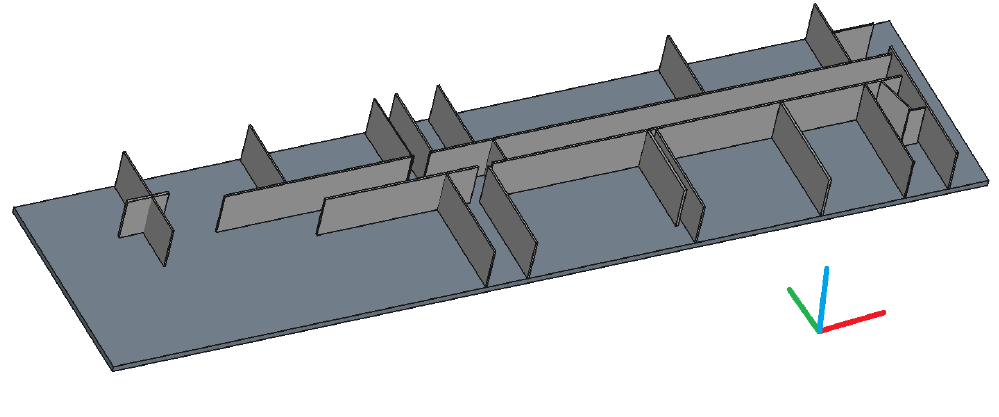
Figure 9. Creation of architectural entities in FreeCAD —1st floor of the INSA building.